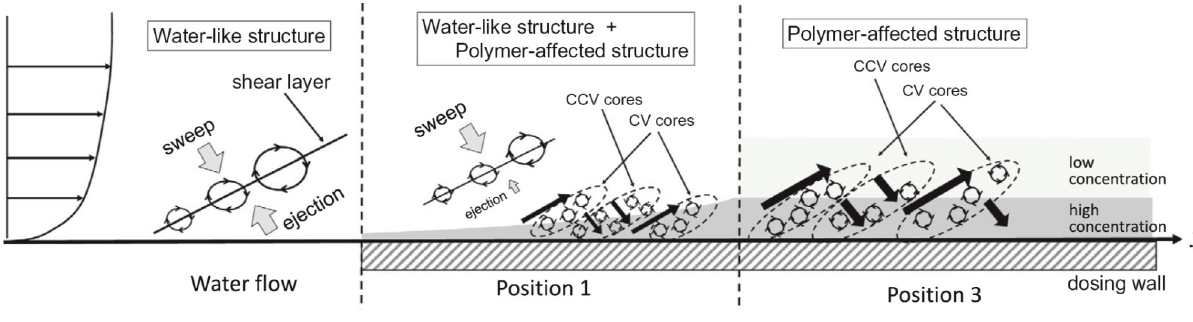
Figure 15. Conceptual model for the streamwise variation of the turbulent structure (Reprinted from